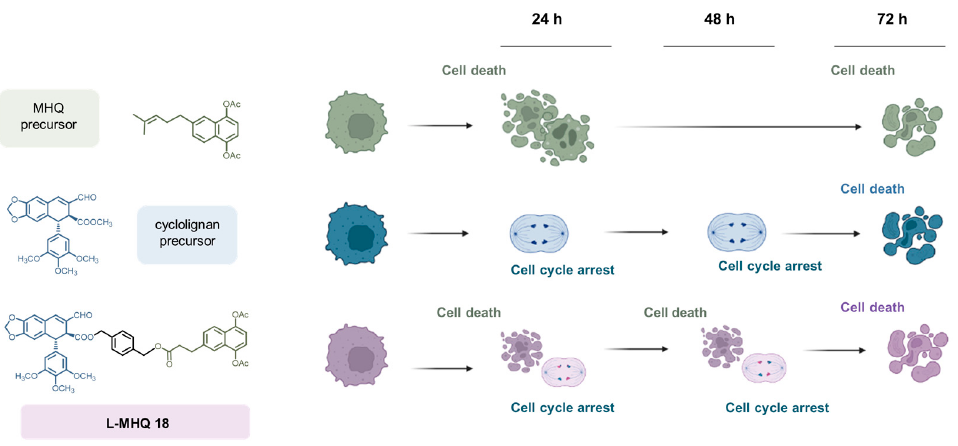
Figure 6. Schematic representation of cell death progression over the incubation time of the precursors 2 and 3 and the L-MHQ 18 in HT-29 cell line.